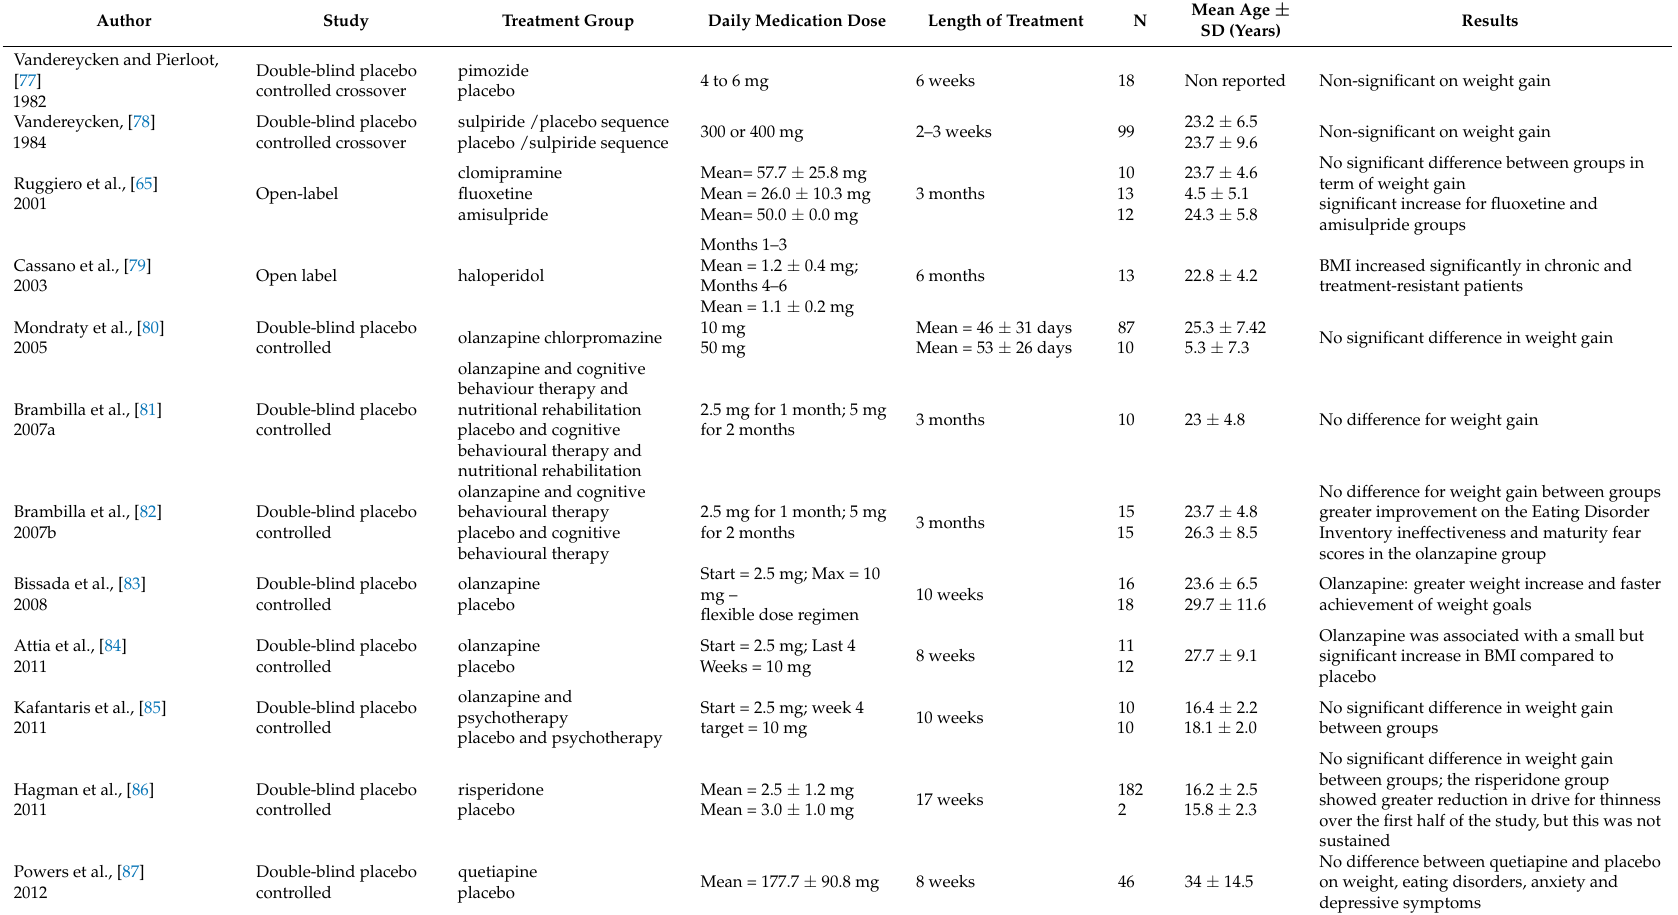
Table 4. Description of neuroleptics and antipsychotics studies